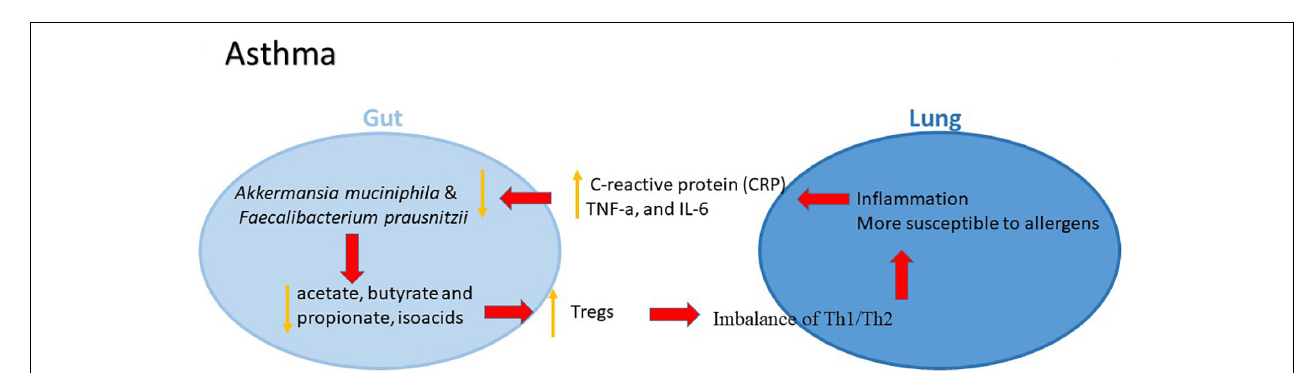
FIGURE 2 | The potential role of gut–lung axis in